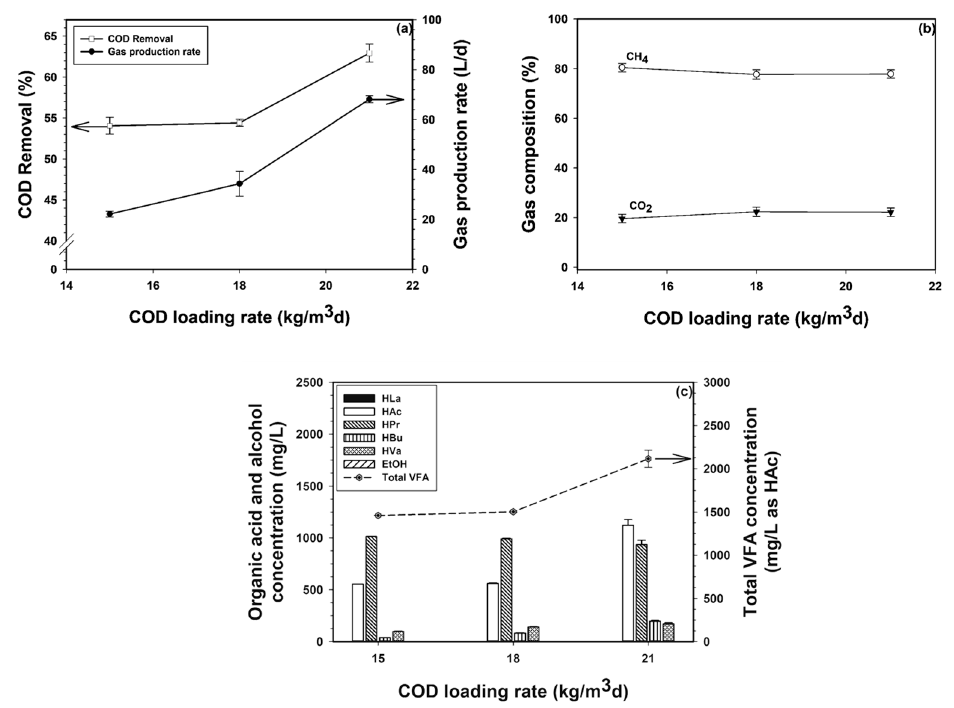
Figure 4. Effect of the COD loading rate on the ( a ) COD removal and gas production rate, ( b ) gas composition and ( c ) total VFA concentration and VFA composition of the third bioreactor operated at 37 °C and 6 cycles/d.